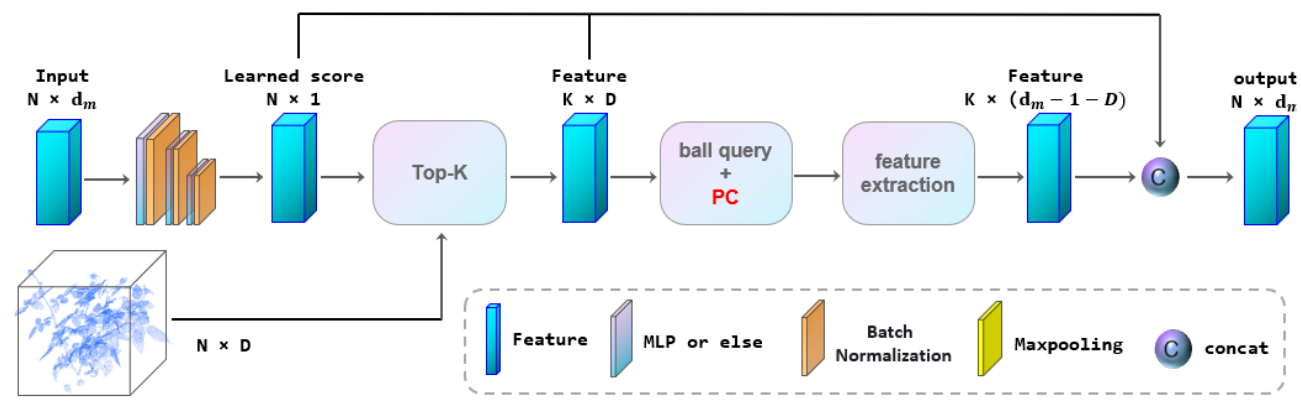
Figure 3. Position code in MSG.